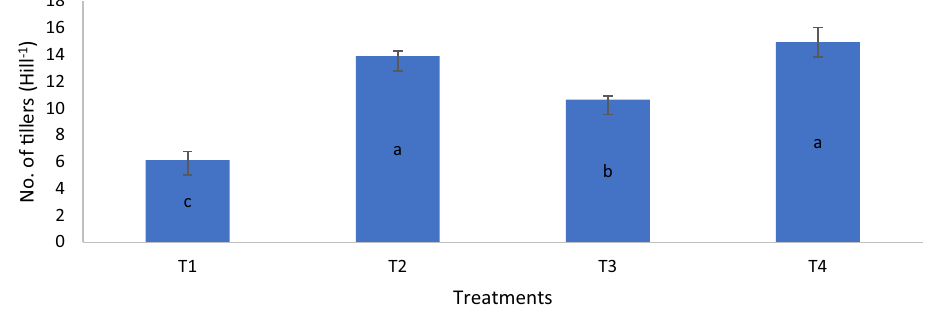
Figure 9. Chicken litter biochar on numbers of tillers of MR219 rice plants cultivated on a tropical acid soil.